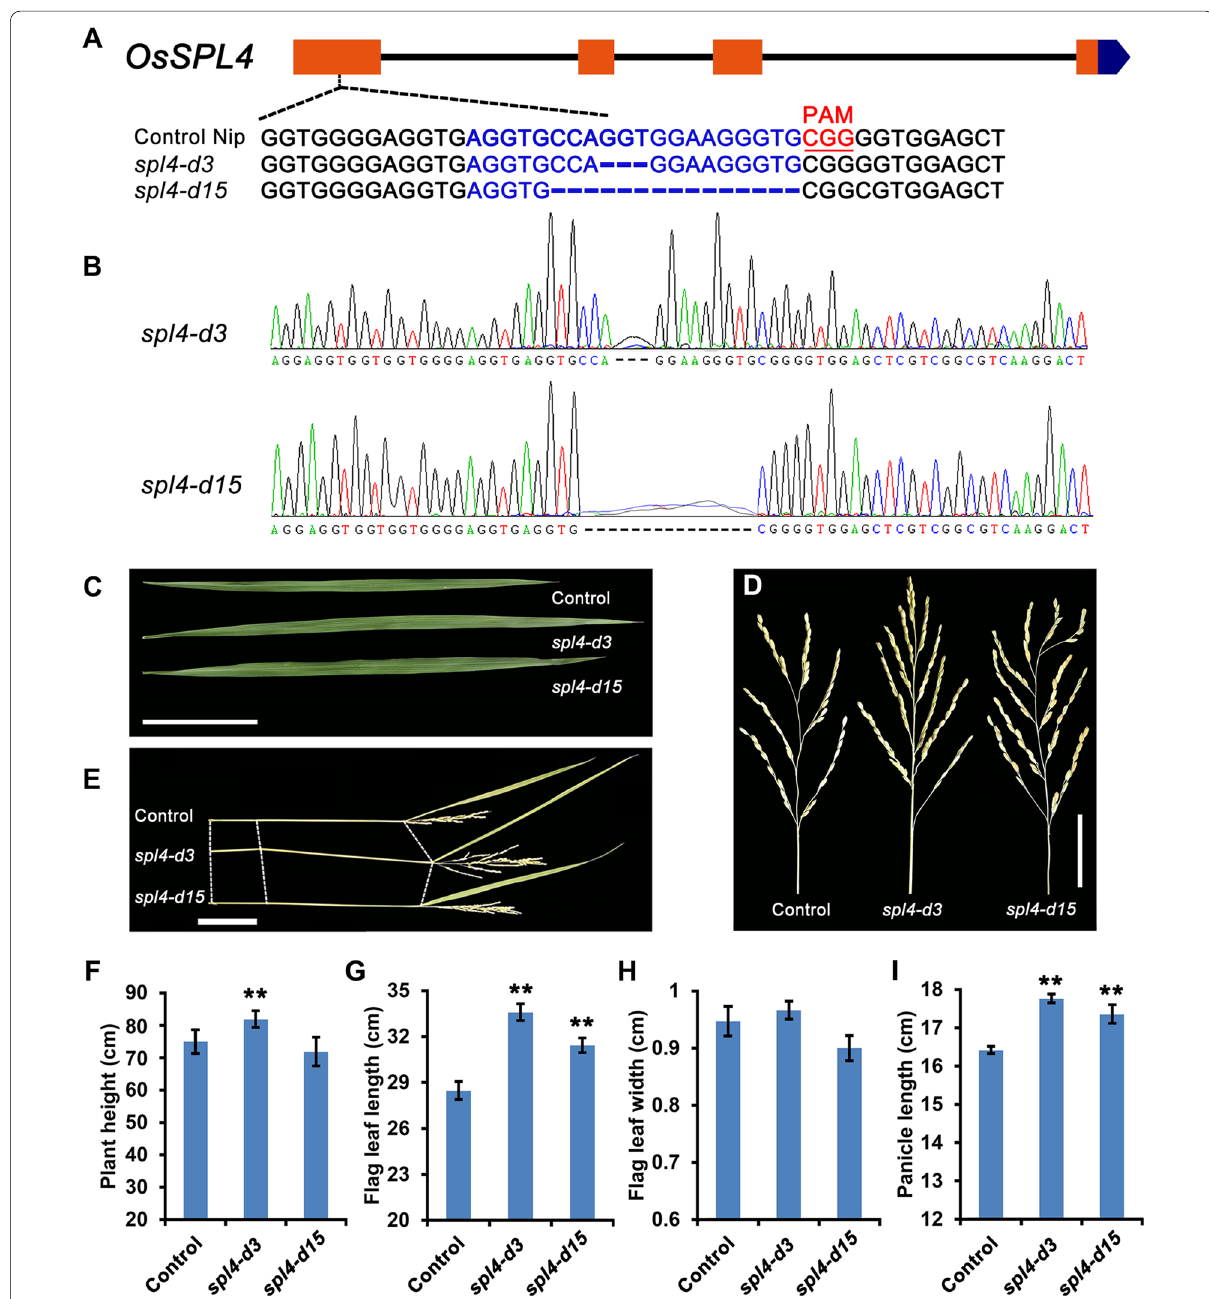
Fig. 1 Pleiotropic effects of the mutants of OsSPL4 in Nipponbare background. A Gene structure of OsSPL4 and the sequence alignment between the mutants in T3 generation and control plants. Nip, Nipponbare. The deleted amino acid residues in the mutants are presented by dashes. The protospacer adjacent motif (PAM) are underlined in red. Two types of mutation events ( spl4-d3 and spl4-d15 ) were generated by CRISPR/Cas9 in Nipponbare rice. B The two different mutation events were confirmed by Sanger sequencing. C – H Comparisons of several important traits among spl4-d3 , spl4-d15 lines and control plants. C Flag leaf, scale bar 10 cm. D Panicle, scale bar 5 cm. E Stem, scale bar 10 cm. F Plant height. G Flag = = = leaf length. H Flag leaf width. I Panicle length. P values were determined by Student’s t test. * P < 0.05, ** P <